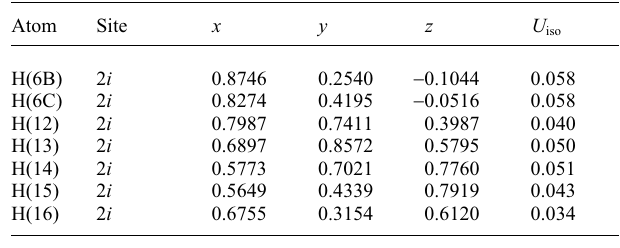
Table 3. Atomic coordinates and displacement parameters (in Å 2 ) .